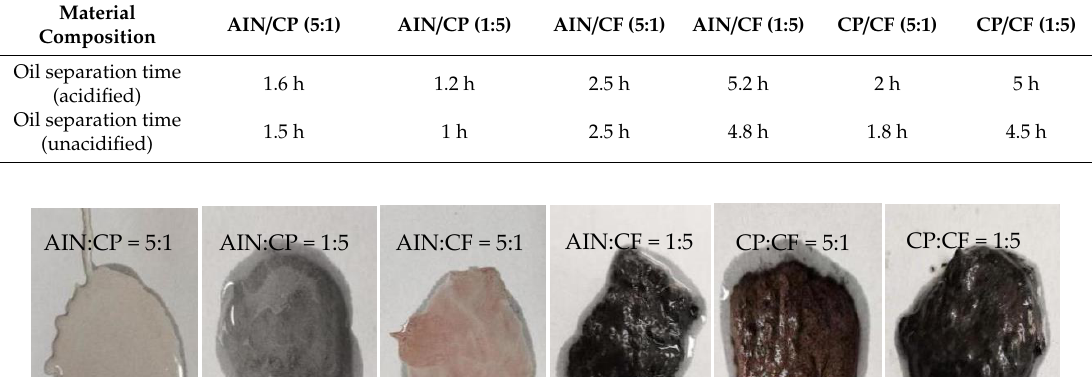
Table 2. Oil separation time of different components of thermal grease.